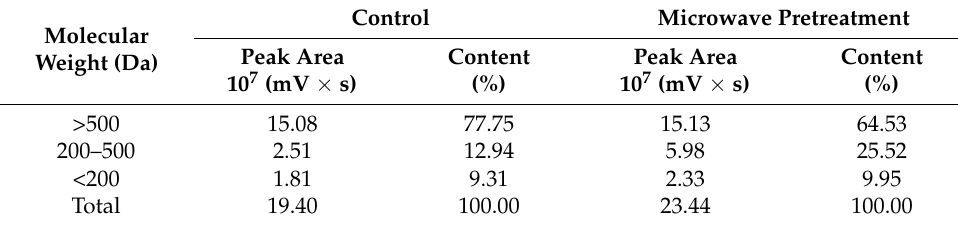
Figure 6. Chromatogram of molecular weight distribution of hydrolysate from MP. ( A ) Control (without the microwave power of 0 W) and ( B ) microwave pretreatment of MP with the power of 300 W. Table 1. The molecular weight distribution of hydrolysate from MP.